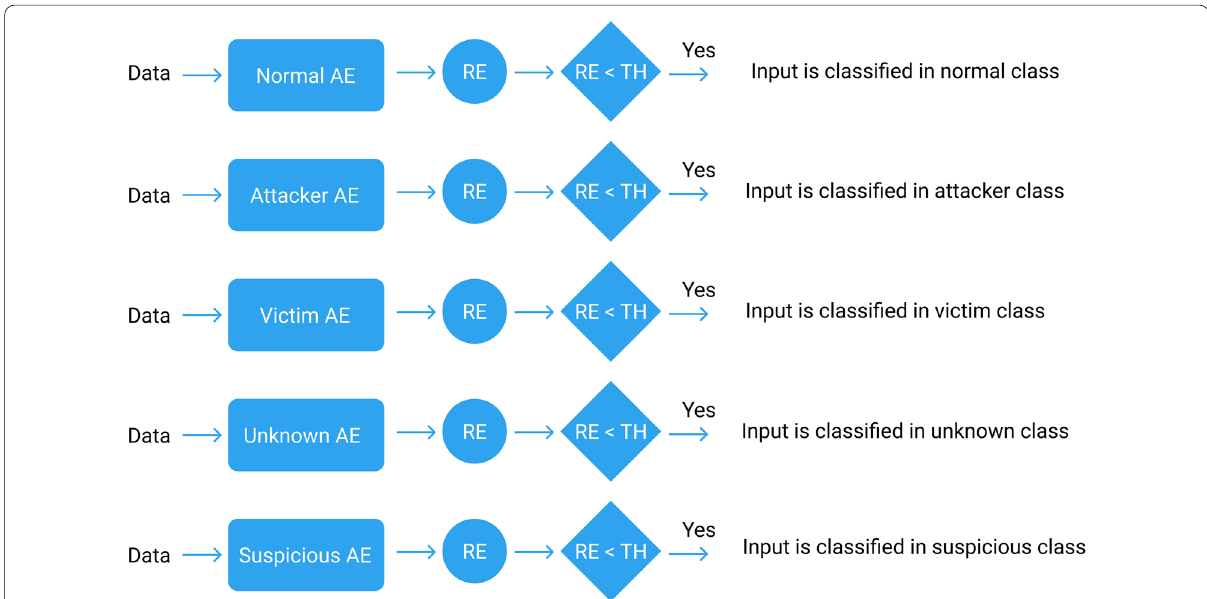
Fig. 8 The evaluation process of anomaly detection and classifiers in the proposed method